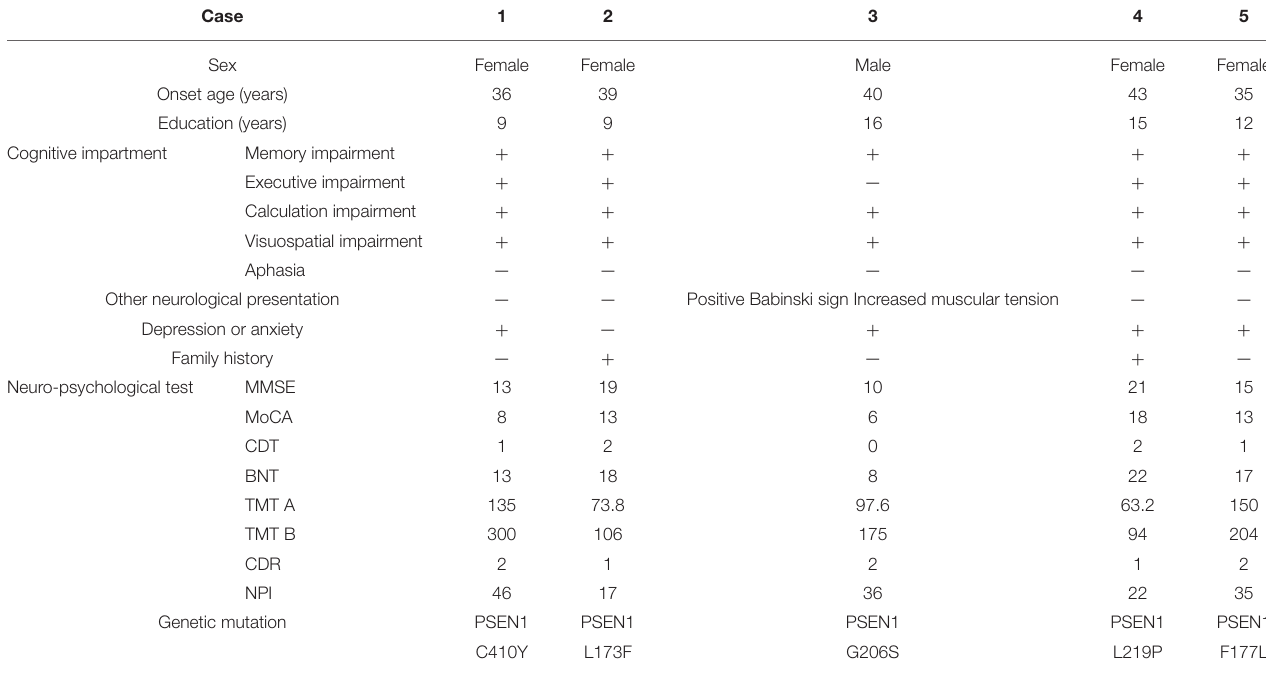
TABLE 1 | Demographics and clinical symptoms of five patients with early-onset familial Alzheimer’s disease (EOFAD).